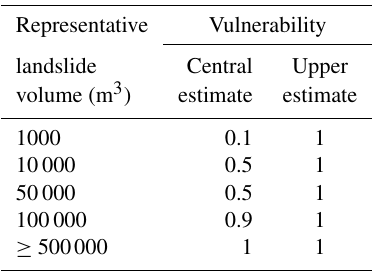
Table 1. Physical vulnerability values used in